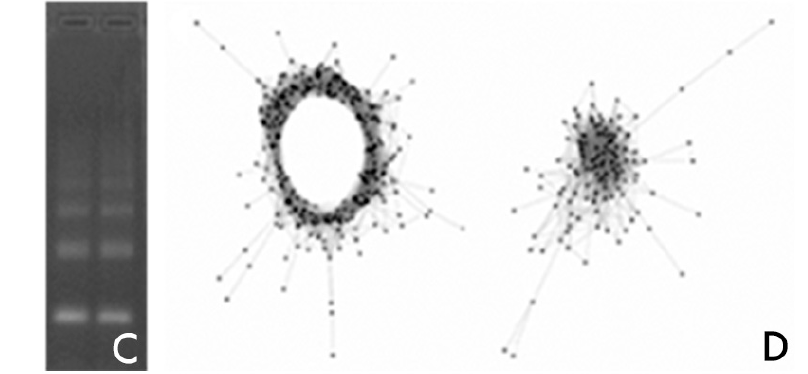
Figure 1. ( A ) After electrophoresis of restriction digested genomic DNA, a distinct prominent band (arrow) against the background smear might be unveiled apparent which contains single fragments corresponding to the individual monomeric members of a satellite DNA (satDNA) family. ( B ) Southern blot hybridization patterns using satDNA probes against genomic DNA digested with different restriction enzymes. The occurrence of a restriction site for a particular enzyme leads to the complete digestion of an array which leads to a band of monomeric units (type A digestion, [53,61]). However, it is common that part of the array remains as a ‘ladder’ of oligomers of the repeat unit since some units have lost the restriction site by mutation ( a , b , c , d , e ). On the contrary, mutation may lead to the appearance of occasional restriction sites in some repeats within the array, which is observed as a type B digestion ( f , g , h ) [53,61]. Patterns of undigested satDNA are found in lines i , j . ( C ). Ladder-like patterns of satDNA amplification by polymerase chain reaction (PCR). ( D ). Examples of repeat clusters of satDNA visualized in the form of graphs where nodes represent sequence reads and edges connect reads with sequence similarities as obtained using RepeatExplorer [74,75].